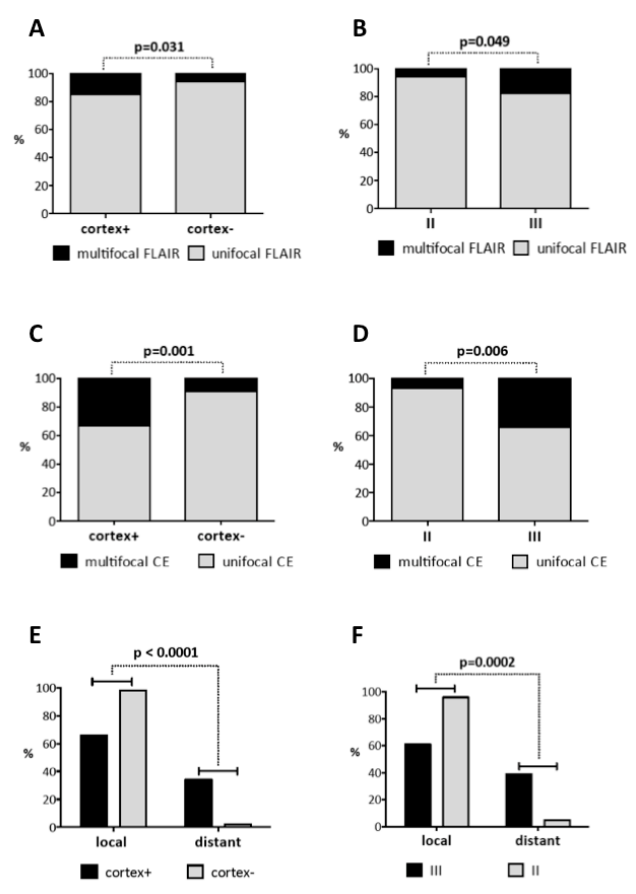
Figure 2. Multifocal growth and distant recurrences were hallmarks of cortical IDH1-wt GBMs. At 1st diagnosis ( n = 285), multifocal FLAIR lesions were significantly increased in cortex+ vs. cortex − ( A ) and group III vs. group II GBMs ( B ), but not in SVZ+ vs. SVZ − GBMs. At recurrence ( n = 187), multifocal CELs were significantly enhanced in cortex+ ( C ) and group III GBMs ( D ). Local and distant recurrence patterns differed markedly within location-specific groups. Distant tumor growth remote from the initial resection site was significantly more frequent in GBMs with cortical involvement (( E ) cortex+ vs. cortex − ; ( F ) group II vs. group